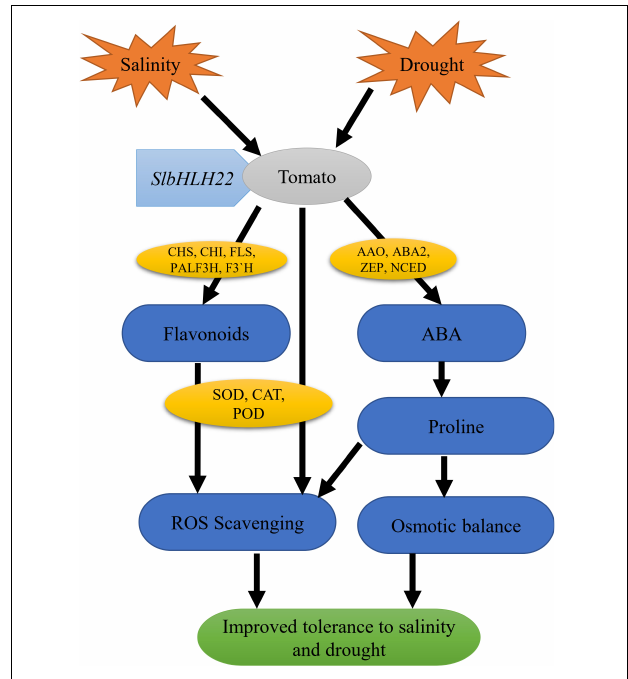
FIGURE 7 | Hypothetical model of SlbHLH22 gene involved in improving drought and salinity tolerance in tomato. Overexpression of SlbHLH22 induced the expression of genes involved in flavonoid biosynthesis, ABA biosynthesis pathway and ROS scavenging genes. This subsequently resulted in altered physiology such as increased ABA accumulation, proline content, and enhanced CAT, POD, SOD activities with reduced ROS accumulation. This led to improve tolerance under abiotic